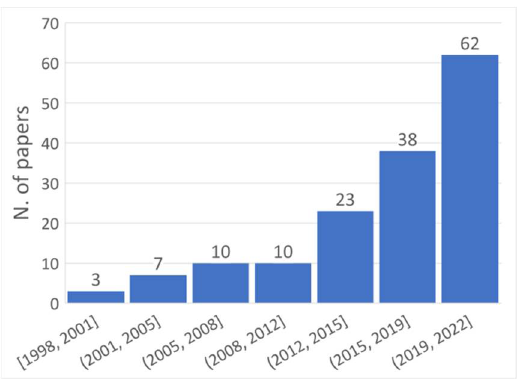
Figure 1. Distribution in time of the analyzed papers per year.